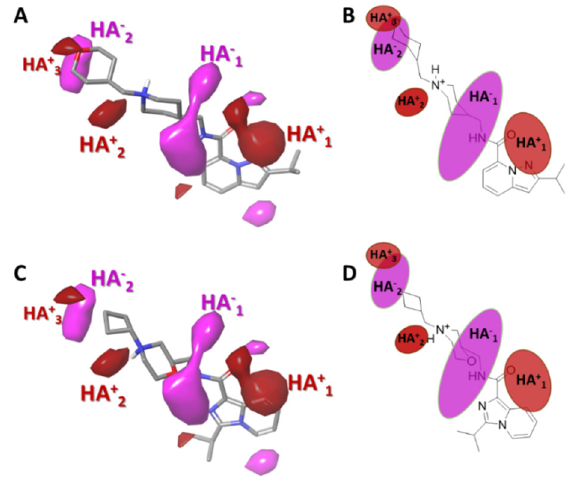
Figure 6. Contour maps obtained for the best Gaussian-based 3D-QSAR model hydrogen bond acceptors (HBA), red and magenta regions indicate a favourable and unfavourable hydrogen bond donor interaction, respectively. The active molecule ( 53 ) is represented in ( A ) (sticks representation) and ( B ) (as draw representation). The less active molecule ( 5 ) is represented in ( C ) (sticks representation) and ( D ) (as draw representation).